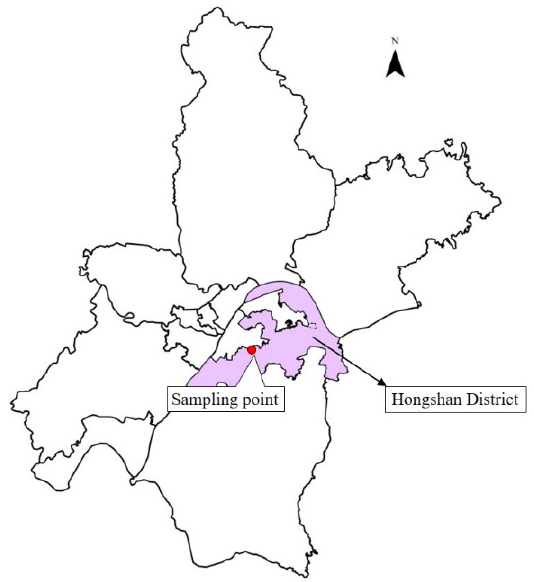
Figure 1. Map showing the location of the sampling point.